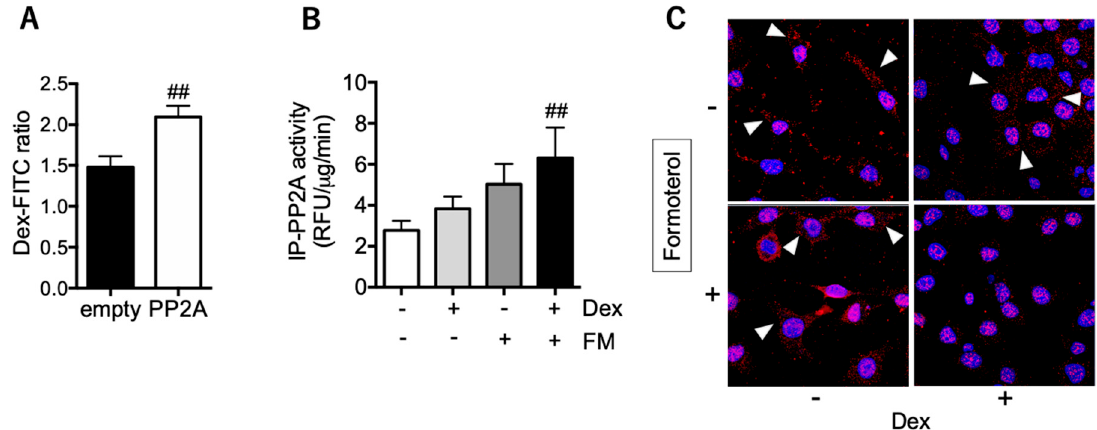
Figure 4. Effect of PP2A overexpression and activation on GR nuclear translocation. ( A ) The PP2A plasmid (or empty plasmid) was transfected in BEAS-2B cells. FITC-conjugated dexamethasone (Dex-FITC: 10 − 6 M overnight) in the nuclei was evaluated and represented the ratio to baseline (time = 0). ( B , C ) Epithelial cells of nasal polyps were pretreated with formoterol (10 − 9 M) for 20 min, followed by incubation with dexamethasone (Dex; 10 − 7 M) for 60 min. PP2A activity ( B ) and Dex-induced GR nuclear translocation ( C ) were evaluated. Values in A and B represent the mean ± SEM values of four experiments: ## p < 0.01 (vs. empty plasmid or vehicle). Arrowheads in C indicate GR located in the cytoplasm. Images were obtained using a Carl Zeiss LSM700 confocal microscope (400 × objective).